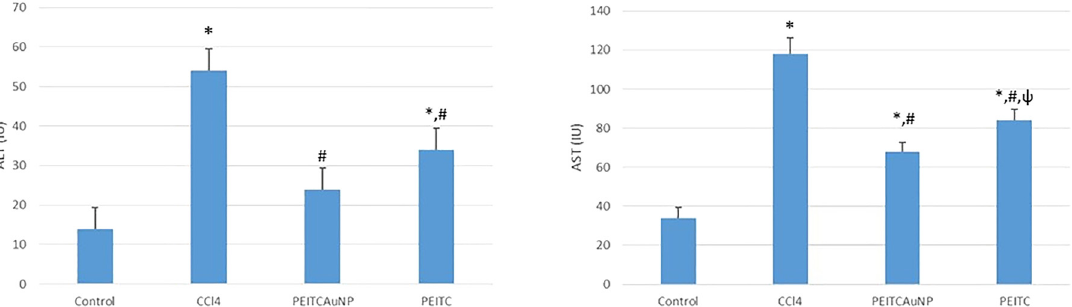
Figure2: E ff ectofPEITC-AuNPonALTandASTlevelsinCCl4-inducedHepG2cells.Dataarepresentedasmean ± S.E.*p<0.05vs.control; # p<0.05vs.CCl 4 ; ψ p<0.05 vs. PEITC-AuNP.